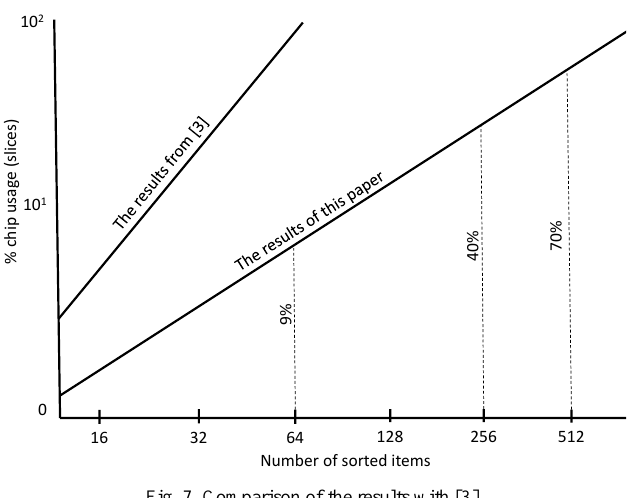
Fig. 7. Comparison of the results with